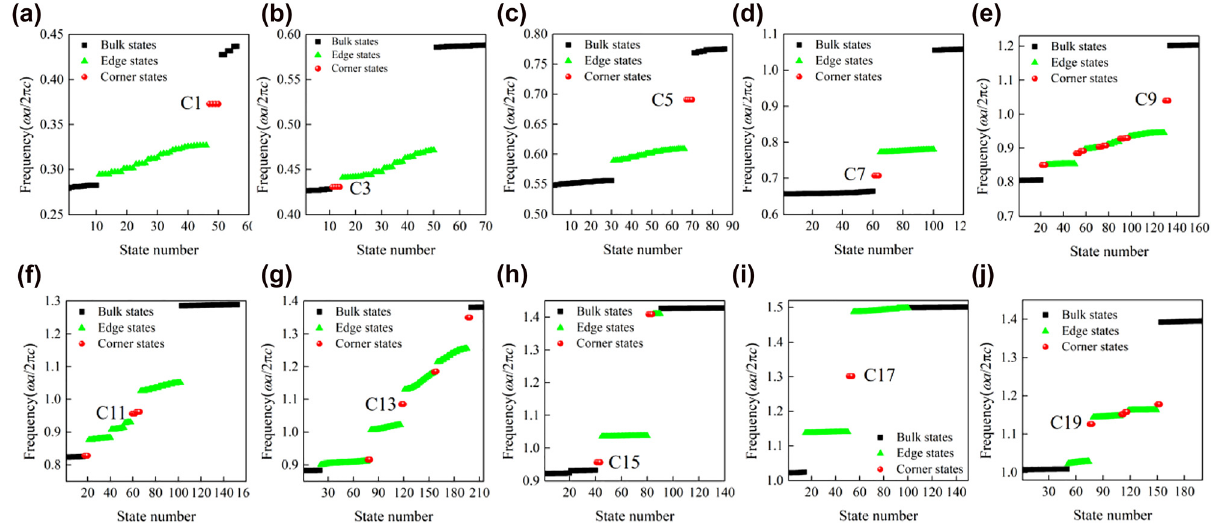
Figure 5: Calculated eigenfrequencies of (a) MS1,(b) MS3,(c) MS5,(d) MS7, (e)MS9,(f) MS11,(g)MS13, (h) MS15,(i) MS17, and(j) MS19.MS n represents that the metastructure is made of UC n A and UC n